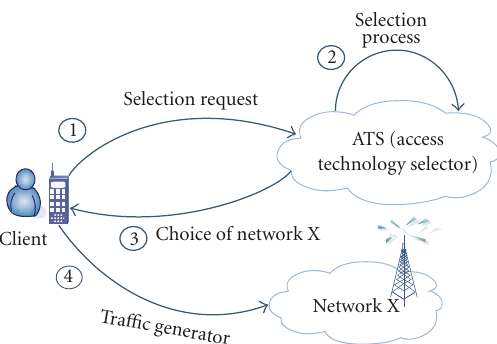
Figure 2: Selection steps implemented in the